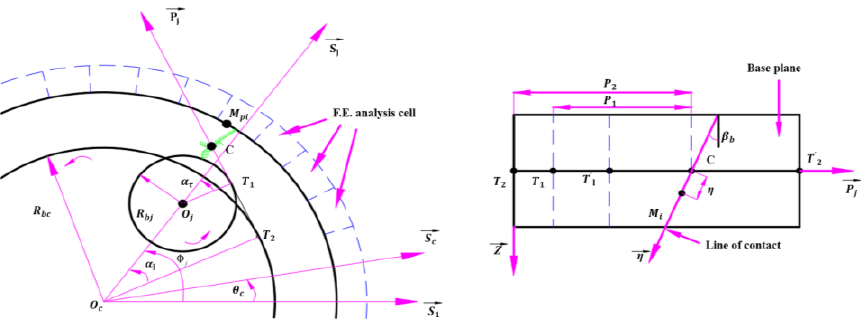
Figure 4. Geometrical parameter for internal gear modeling.